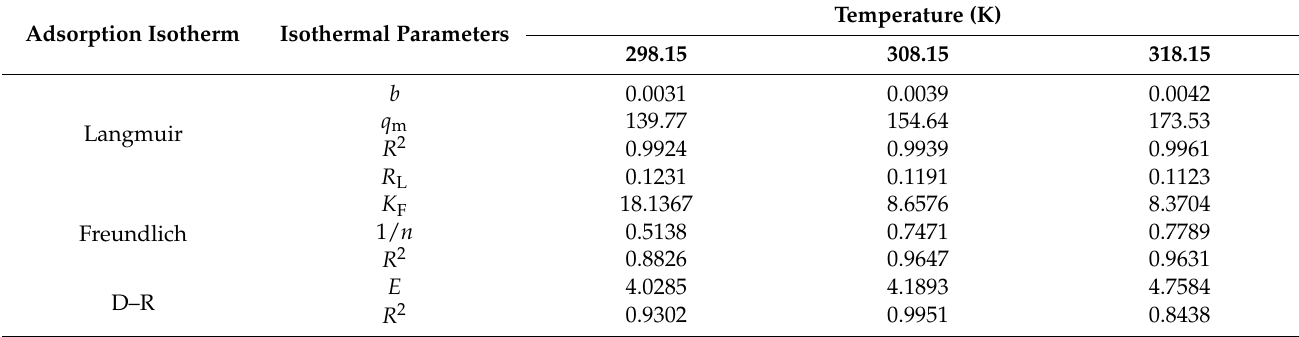
Figure 15. ( a ) Langmuir, ( b ) Freundlich and, ( c ) D–R adsorption isotherm of RhB onto hydrophobic ZrO 2 -SiO 2 xerogel (dosage = 0.05 g, pH = 3, RhB concentration = 140 mg·L −1 , contact time = 120 min, T = 298.15, 308.15 and 318.15 K). Table 3. Adsorption isotherm parameters of RhB on hydrophobic ZrO 2 -SiO 2 xerogel at various tem- peratures.